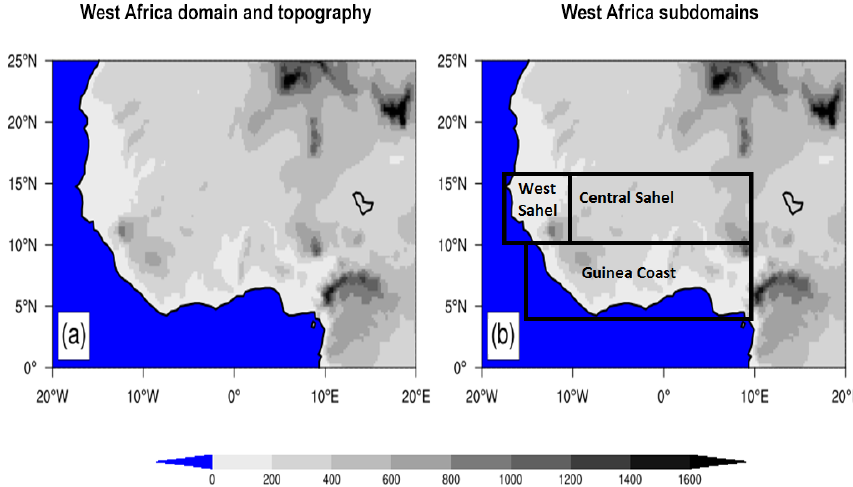
Figure 1. Topography of the West African domain. The analysis of the model results has an emphasis on the whole West African domain and the three subregions, the Guinea coast, Central Sahel and West Sahel, which are marked with black